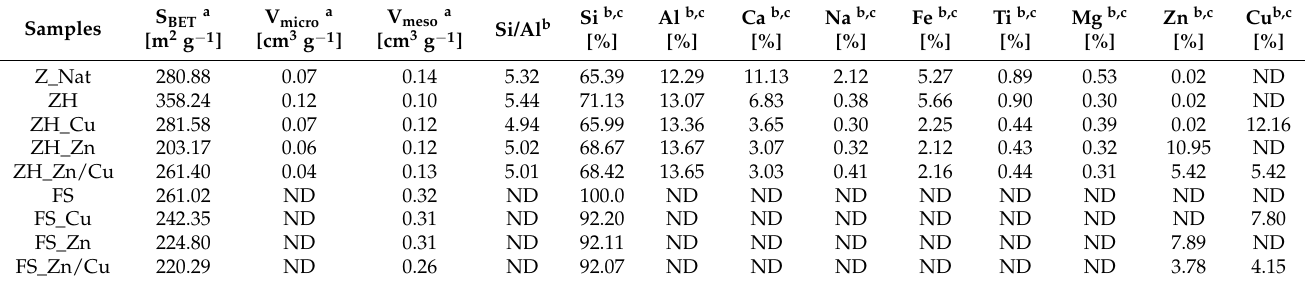
Table 1. Physical–chemical surface properties of parent zeolite and fumed silica supports and single and double metal oxide catalysts supported on modified natural zeolite and on fumed